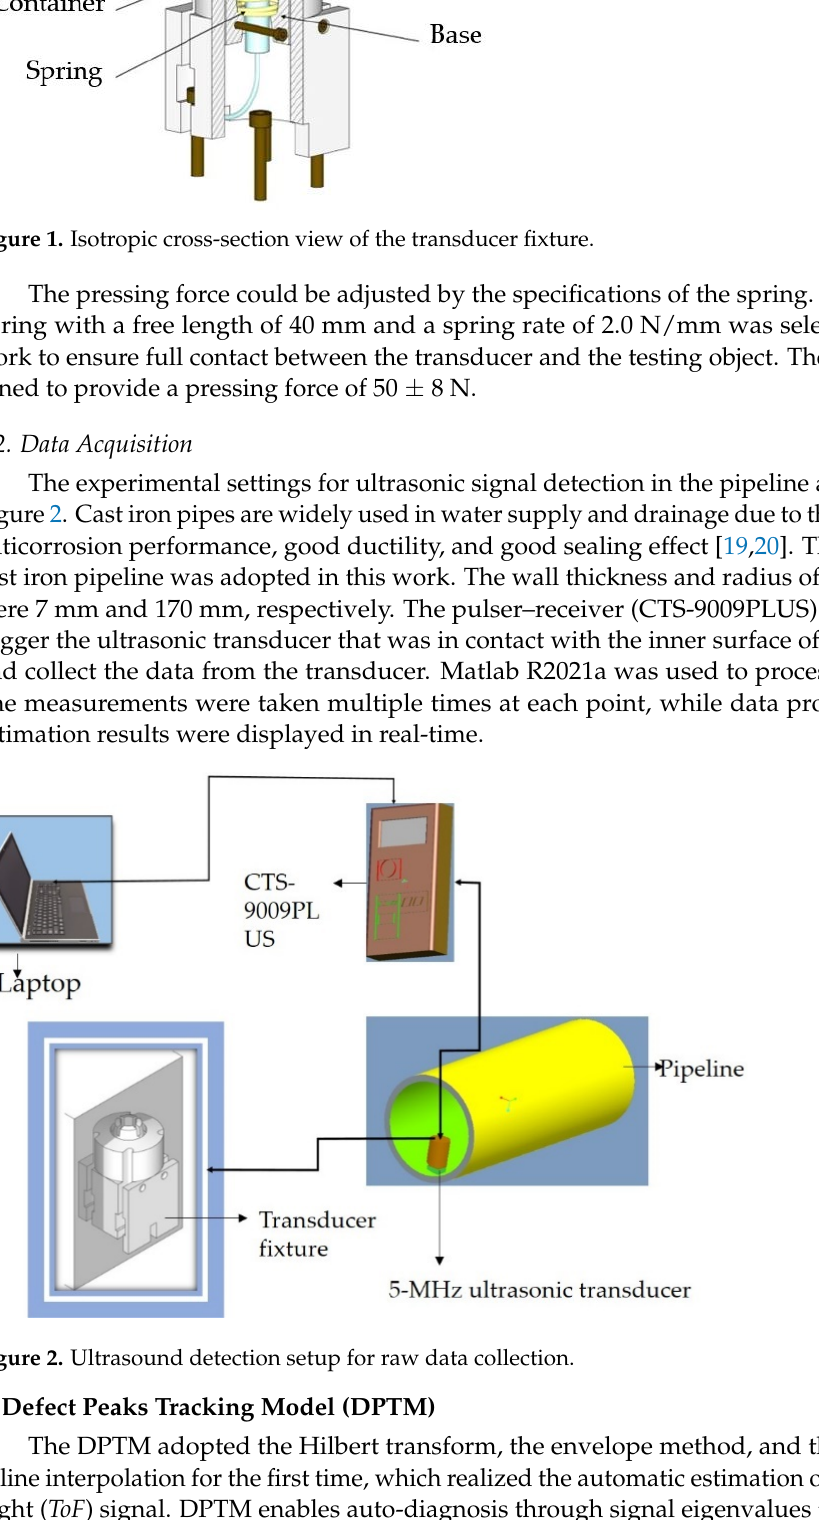
Figure 1. Isotropic cross-section view of the transducer fixture.